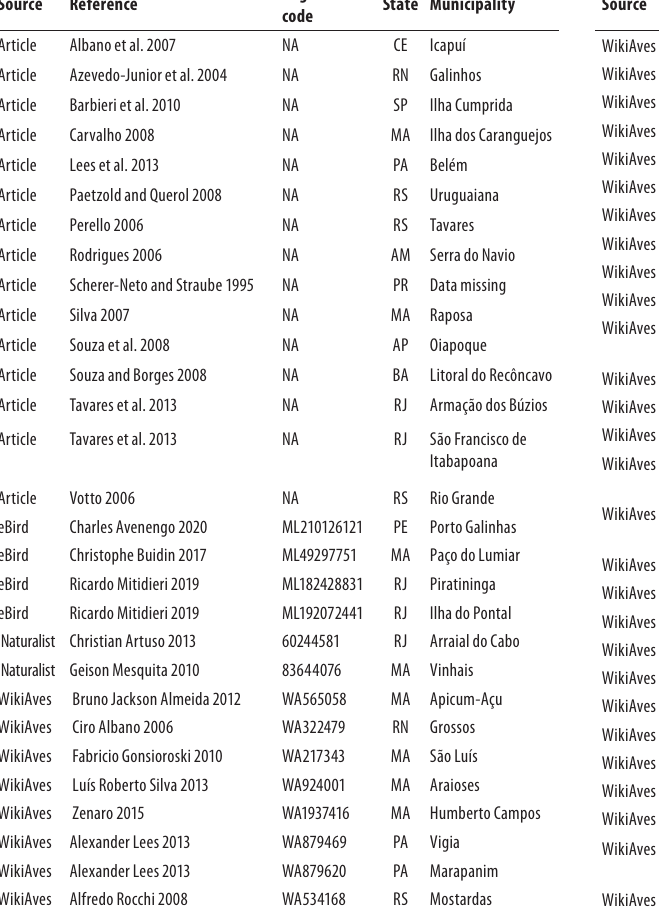
Table A1. Dataset from the scientific literature and online databases (eBird, GBIF, iNaturalist, speciesLink and WikiAves) used to create Fig- ure 1. Only the oldest record for each municipality of Brazil is included, and we only considered citizen-science records with photographs.